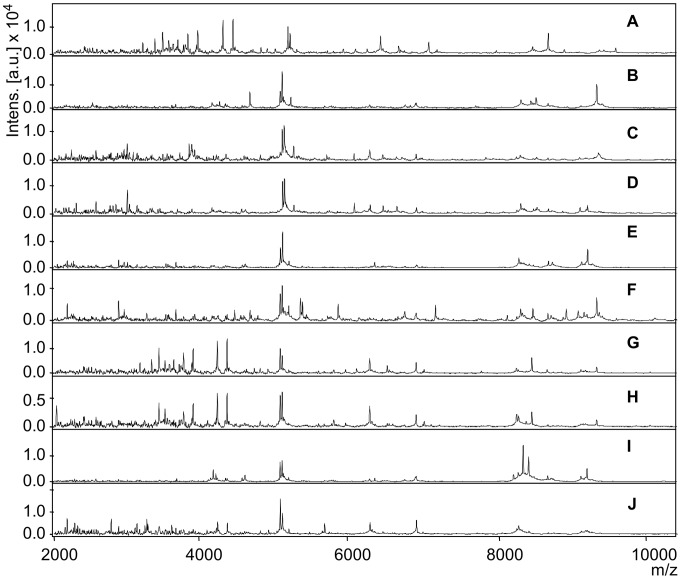
Representative spectra of whole insect extraction of male and female Glossina spp.Mass spectra peak pattern of whole insect extractions of male and female Glossina (G.) spp. The x-axis m/z value stands for mass to charge ratio and the relative intensity of the ions (a.u., arbitrary units) is shown on the y-axis. A) G. morsitans morsitans female, B) G. morsitans morsitans male, C) G. austeni female, D) G. austeni male, E) G. pallidipes female F) G. pallidipes male, G) G. palpalis gambiensis female, H) G. palpalis gambiensis male, I) G. brevipalpis female, and J) G. brevipalpis male.